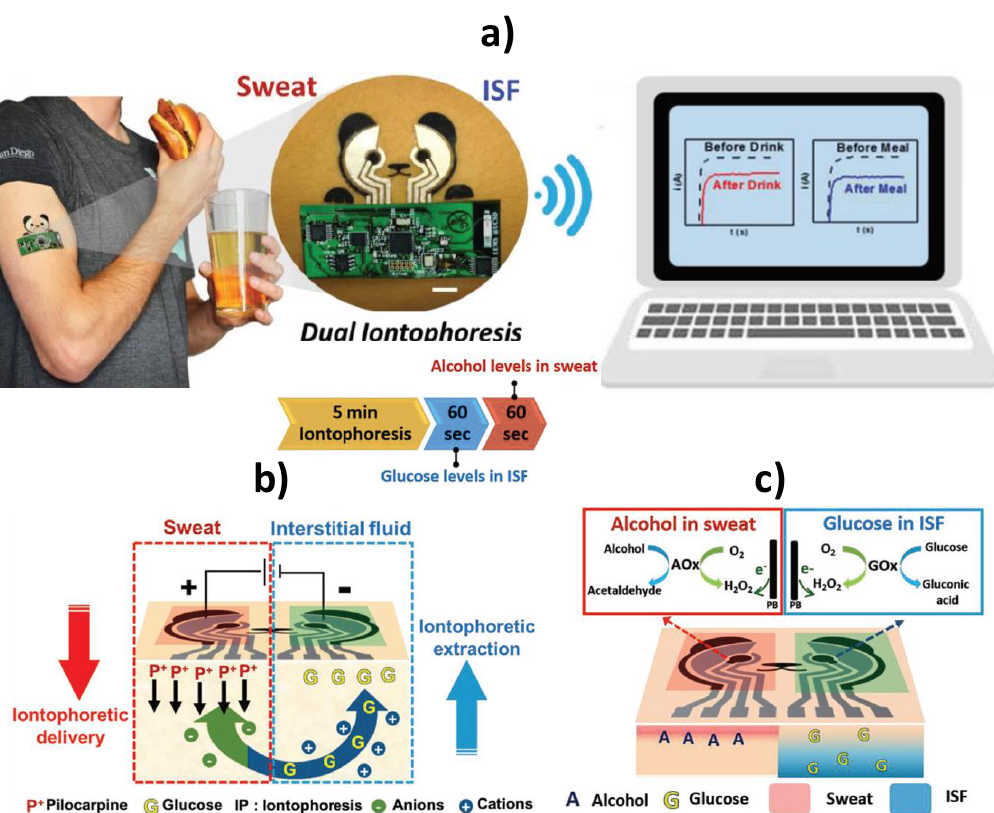
Figure 9. Wearable iontophoretic biosensing device developed on a printed tattoo platform for simultaneous glucose and alcohol monitoring in interstitial fluid (ISF) and sweat, respectively, and wireless real-time transmission of the recorded response ( a ). Schematic display of the iontophoretic operation to simultaneously induce generation of alcohol-containing sweat by iontophoretic delivery of pilocarpine at the anode and sampling of ISF glucose at the cathode by reverse iontophoretic ( b ); biosensing operations to detect amperometrically alcohol in the stimulated sweat and of glucose in the extracted ISF by measuring the hydrogen peroxide generated in the AOx and GOx enzymatic reactions ( c ). Reprinted and adapted with permission of Wiley [83].